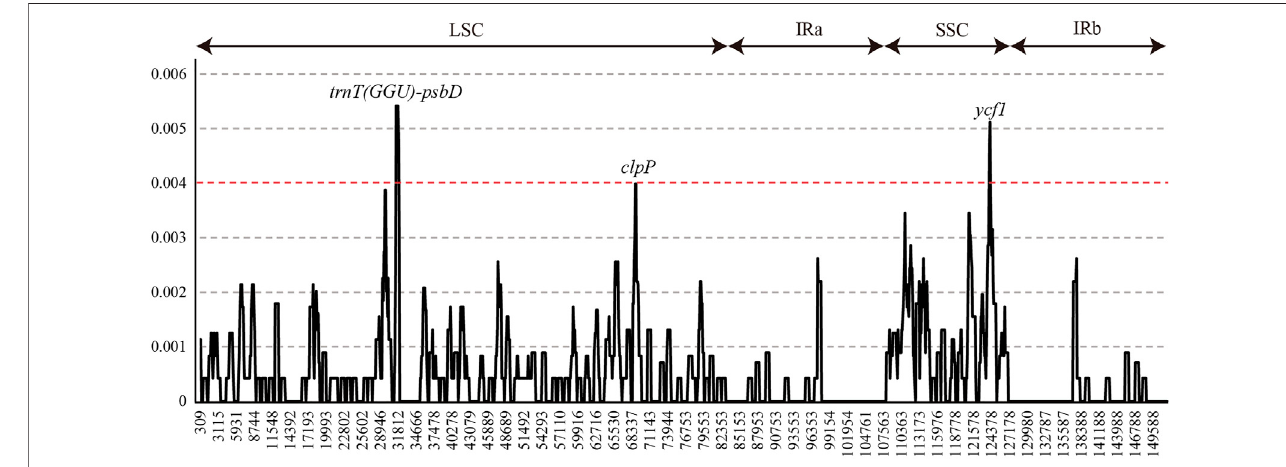
FIGURE 4 | Sliding-window analysis of the whole chloroplast genomes of all L. cardiaca accessions.